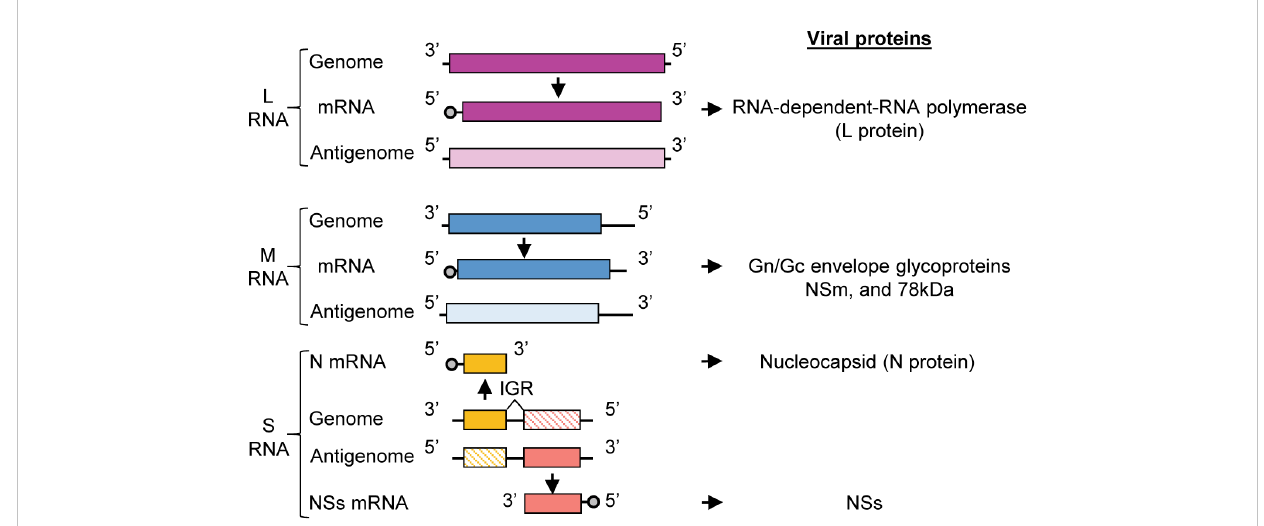
FIGURE 1 RVFV genome organization. RVFV RNA genome consisting of L, M, and S RNA segments. Genomic segments are negative sense and serve as templates for the generation of complementary antigenomic RNAs. The sizes of RVFV RNA segments are: L (6404 nt), M (3885 nt), S (1690 nt). The genomic strands of L and M segments are used to transcribe the L and M mRNAs, respectively. L mRNA encodes L protein and the M mRNA encodes the Gn/Gc glycoproteins, NSm, and 78kDa protein. The S segment utilizes an ambi-sense coding strategy wherein the N mRNA is transcribed from the genomic RNA and NSs mRNA is transcribed from the antigenomic RNA. N mRNA encodes for N protein and NSs mRNA encodes for the nonstructural protein, NSs. IGR, intergenic